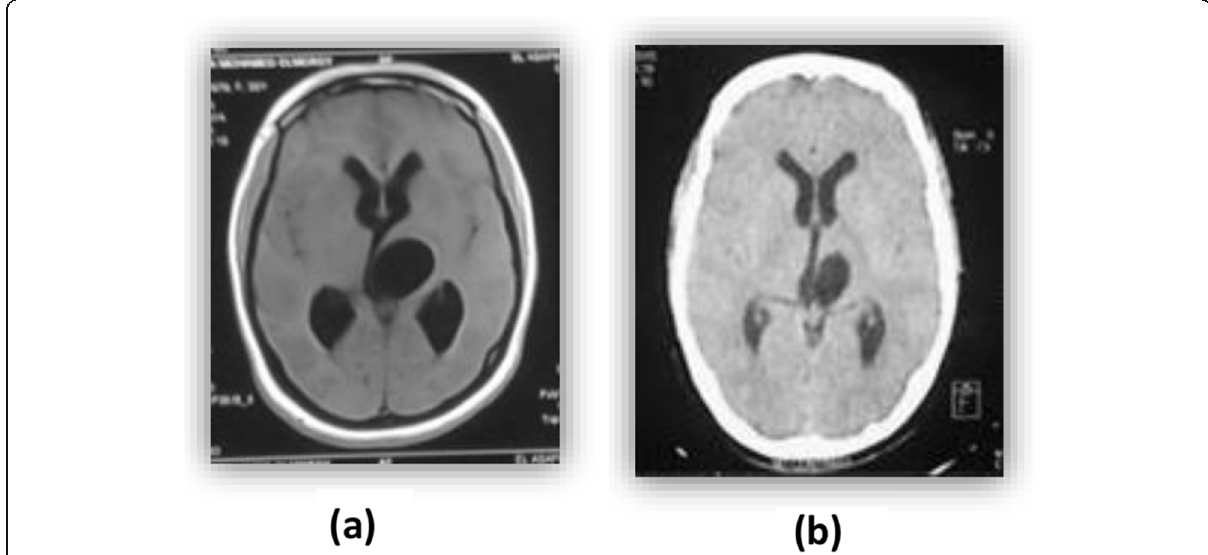
Fig. 5 a MRI T1 axial sequence showing left quadrigeminal cyst in 45 y old female patient. b Follow-up CT brain after 1 month postoperatively showing reduction of the cyst size. The procedure applied was endoscopic ventriculocystostomy through left frontal burr hole and left lateral